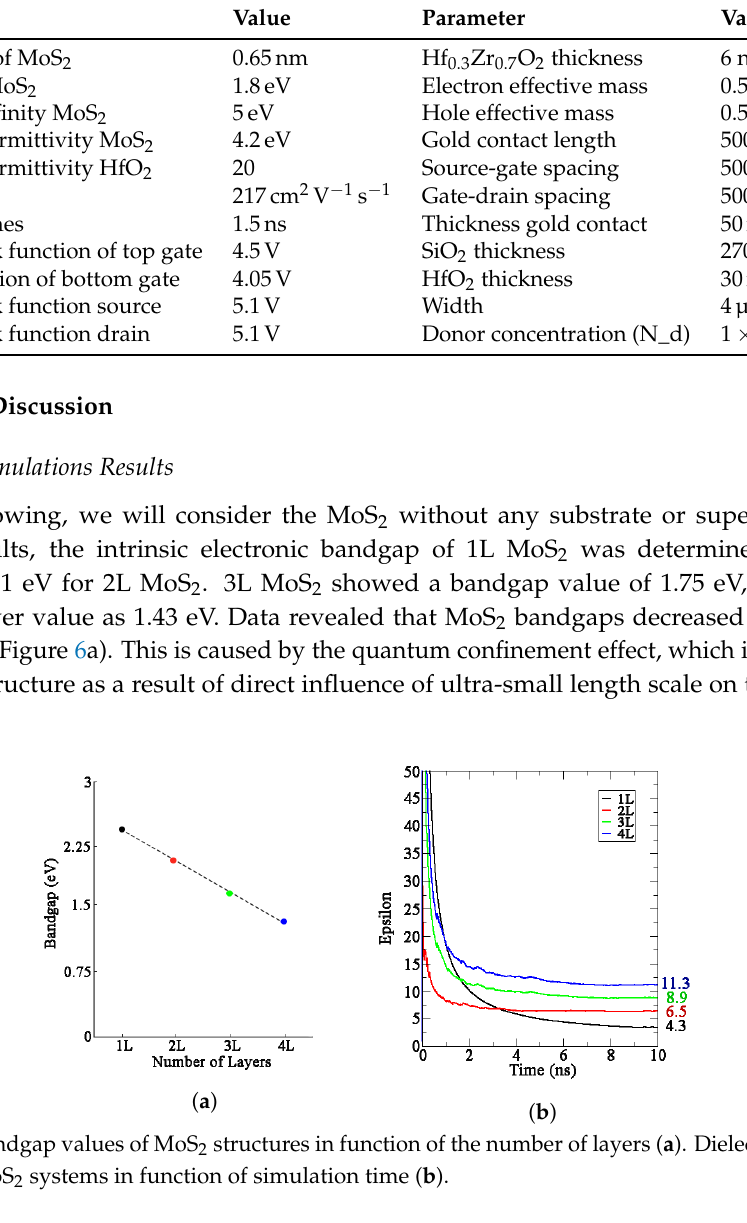
Table 3. Simulation parameters. All the data are taken from [10,28].